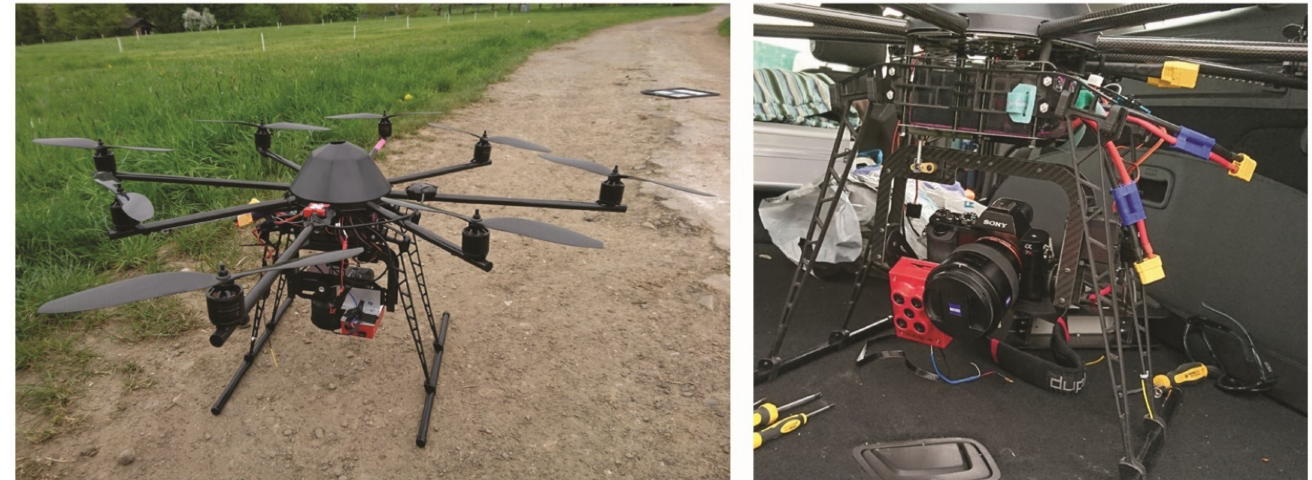
Figure 4. Multirotor UAV equipped with MicaSense RedEdge-M and Sony Alpha 7r